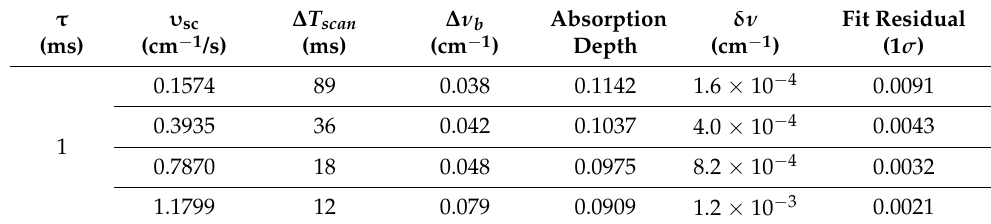
Table 2. Analysis of BB-based heterodyne spectra (Figure 9) of CH 4 absorption with the used time constants ( τ ) of 1 ms at different scanning speeds of the LO frequency ( υ sc ). (Note: the halfwidth